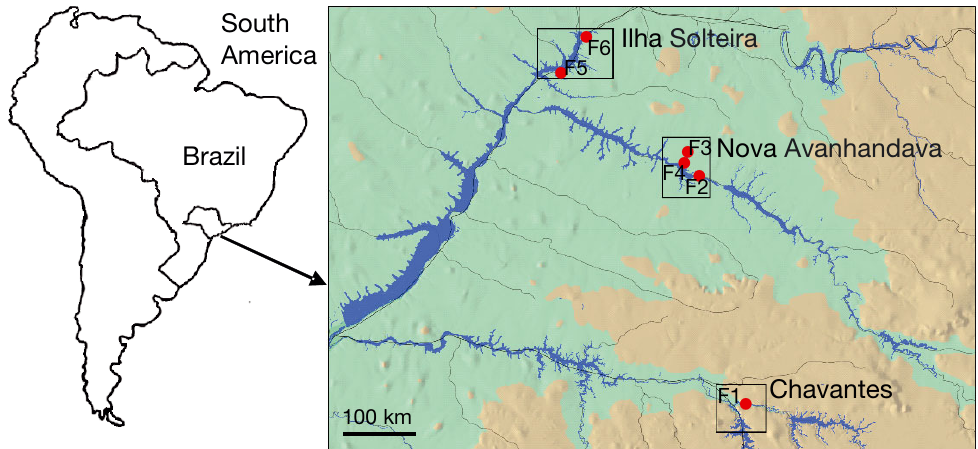
Fig. 1. Location of the reservoirs with the fish farms (red dots, F1–F6) in the main rivers of the upper Paraná basin,